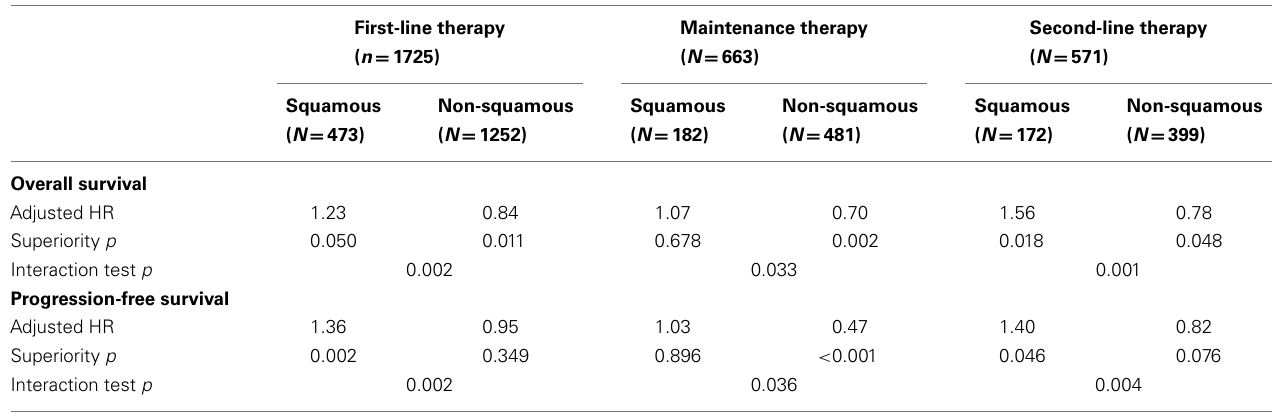
Table 1 | Pemetrexed-histology interaction in randomized clinical trials of NSCLC